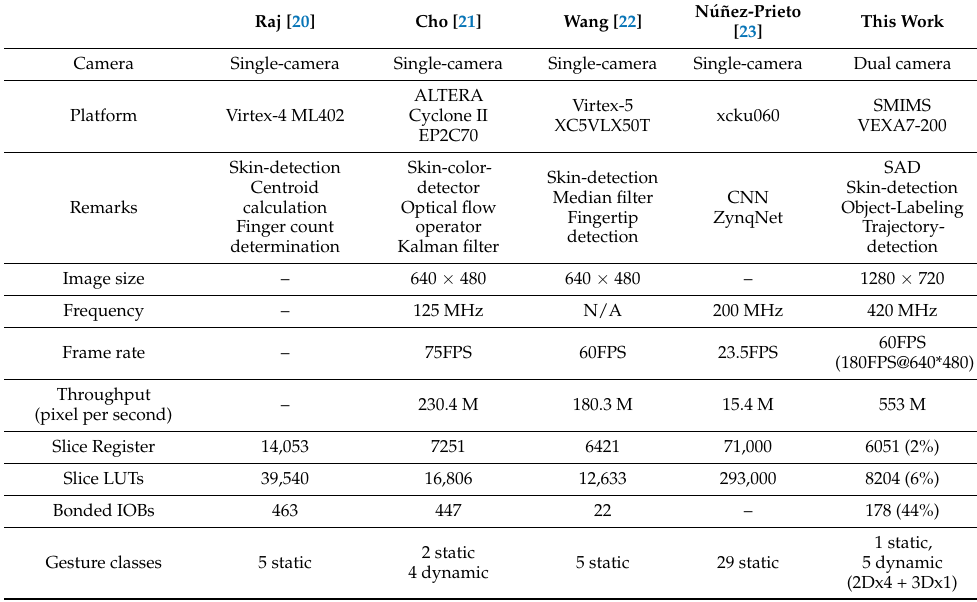
Table 1. The comparison of each researcher.